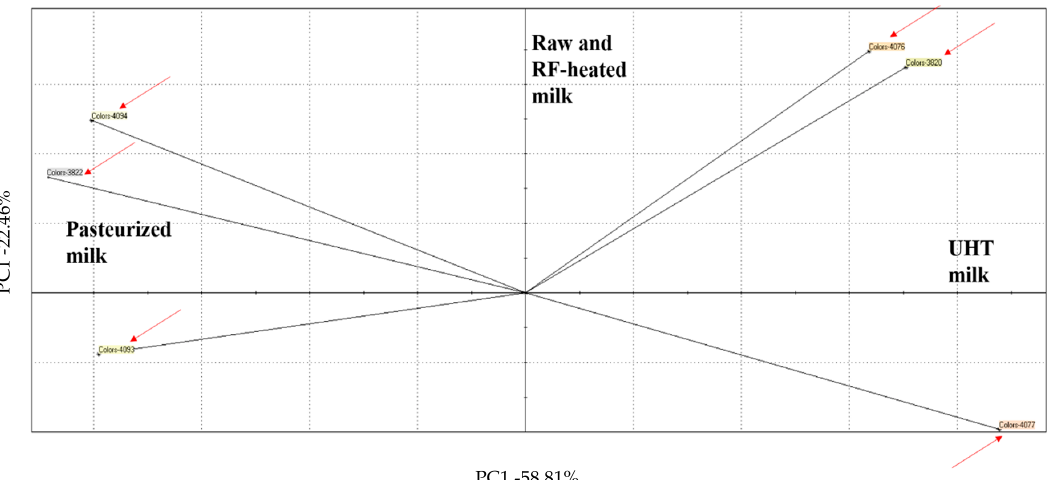
Figure 5. PCA for computer vision with loadings plot.